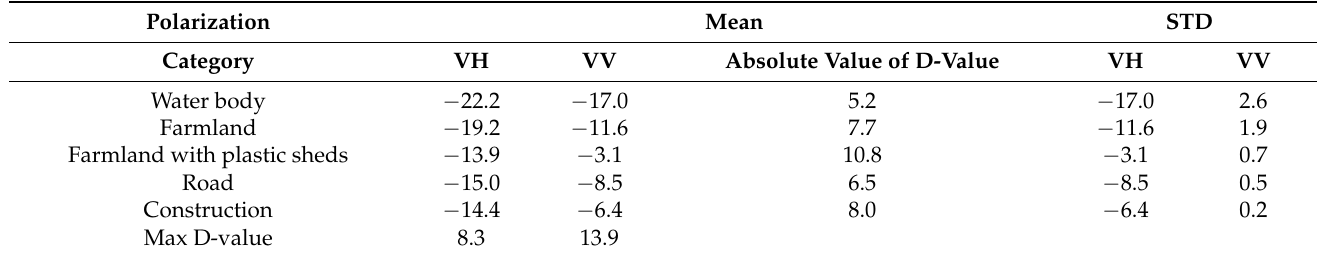
Table 3. Statistical values of backscattering coefficients with integrated orbit (Unit: dB).